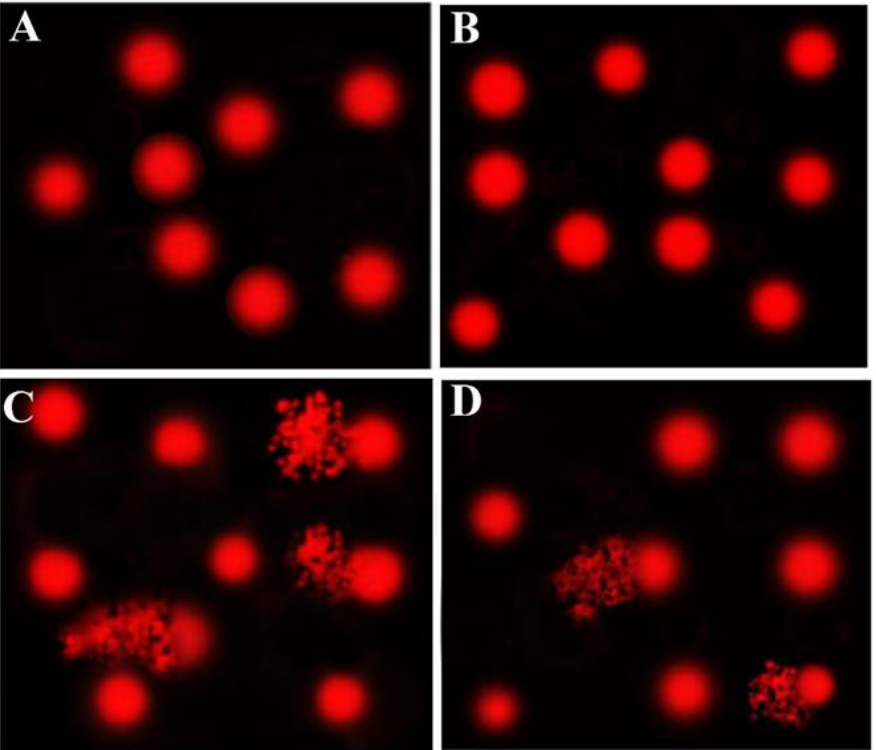
Figure 2. The effects of AvS and/or CsA on the DNA damage of renal cells as detected by comet assay. Comet assays were performed in three independent experiments, and the images here are representative. ( A ) Cnt, ( B ) AvS, ( C ) CsA, ( D ) AvS + CsA. Degraded DNA appears as fragmented patches behind the intact DNA (circle), as seen in ( C , D ).